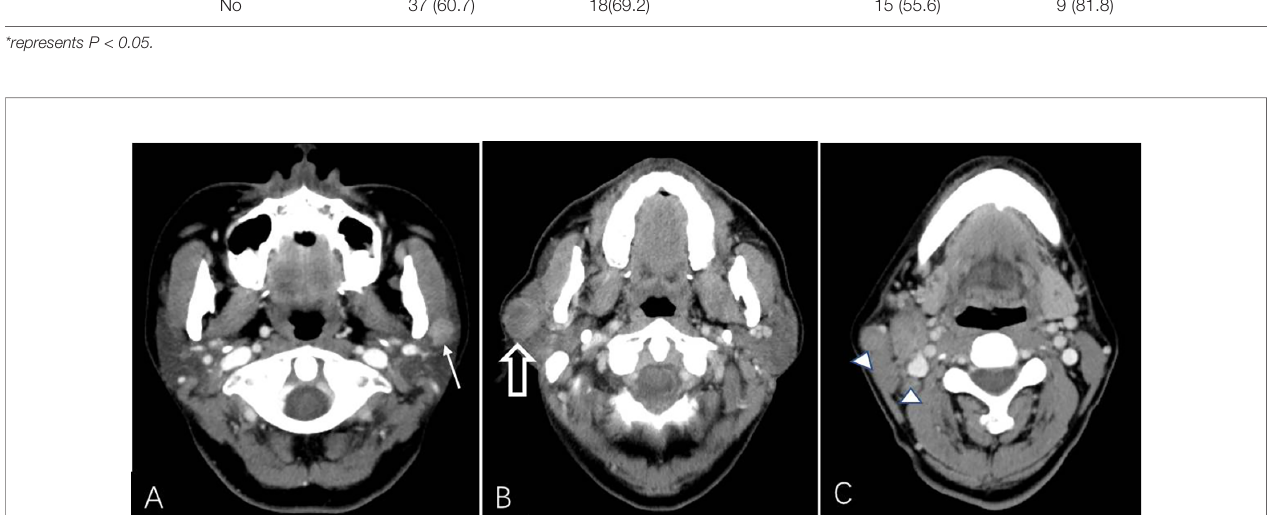
FIGURE 3 | CT example images of benign and malignant parotid tumors. (A) Axial plain CT image of a 60-year-old male patient without a smoking history presenting with a left neck mass (solid white arrow). The patient had undergone parotidectomy 3 days after CT examination, and the mass was histopathologically con fi rmed as a Warthin tumor. (B, C) Axial contrast-enhanced CT image of a 59-year-old male patient with a 20-year smoking history presenting with a right neck mass (open white arrow, B ) that was surgically removed and histopathologically con fi rmed as a salivary ductal carcinoma with lymph node metastasis ( △ , C ). The mass shows heterogeneous enhancement with an irregular and unclear